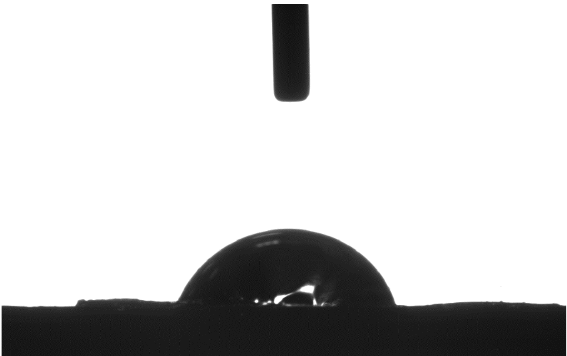
Figure 6. Static water contact angle of graphite foil without He-DBD jet treatment.